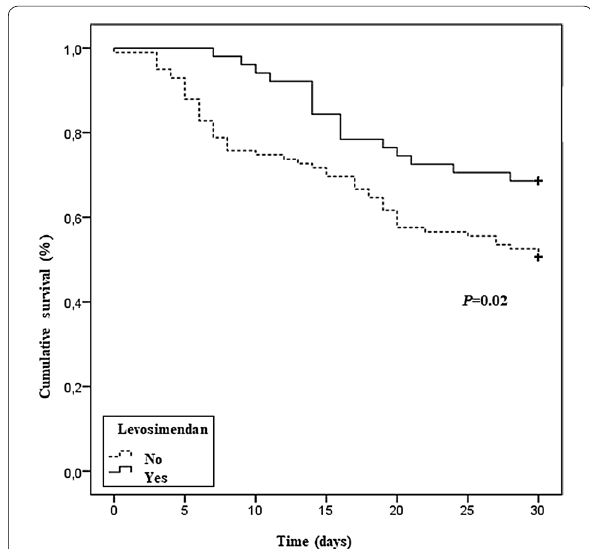
Fig. 2 Survival rate for patients with or without levosimendan by Kaplan–Meier